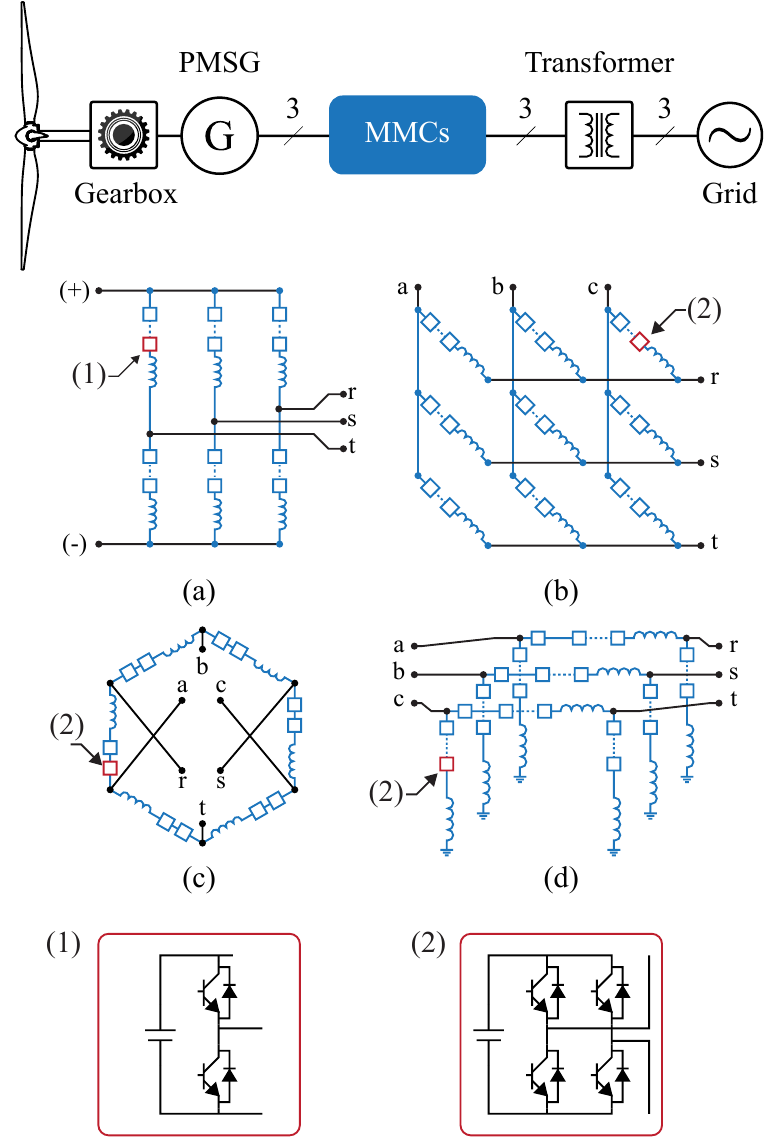
Figure 7. ( a ) M 2 C. ( b ) M 3 C. ( c ) Hexverter. ( d )